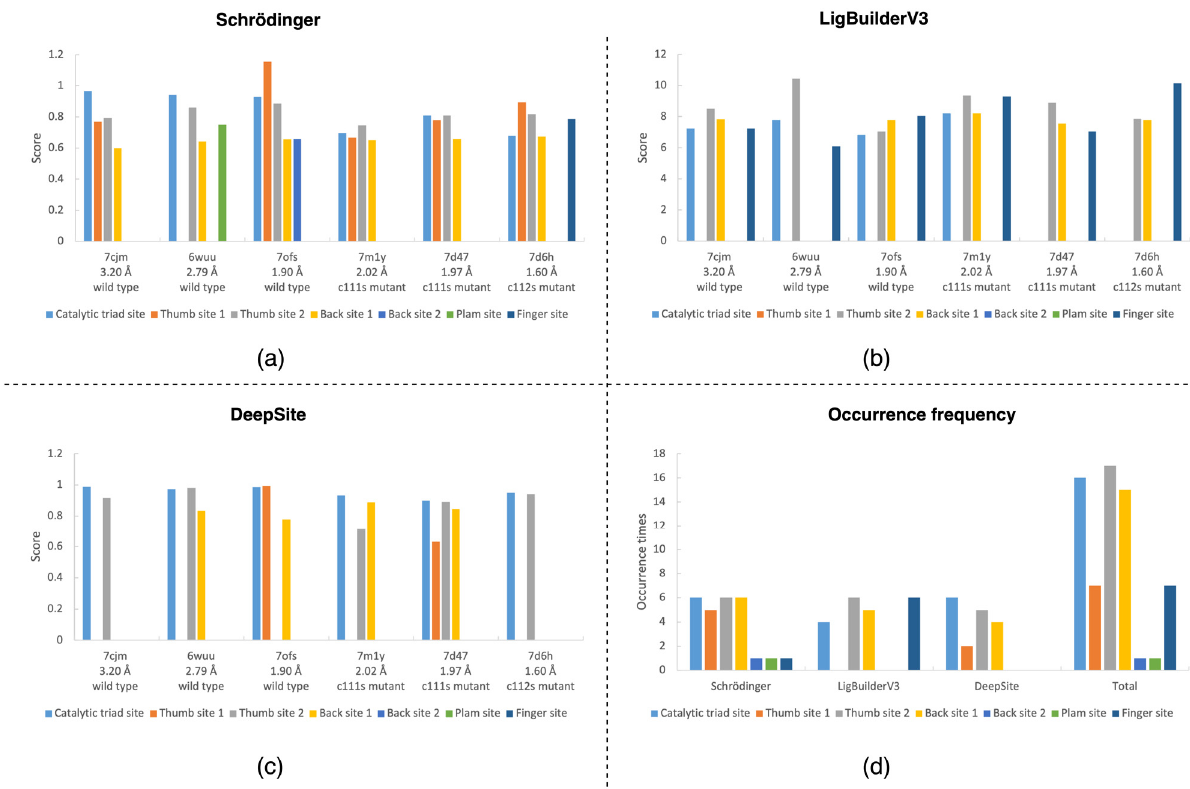
Figure 3. Site detection location map and main sites score statistics: ( a ) Schrödinger’s sitemap results. ( b ) Cavity of LigBuilderV3 test results. ( c ) Binding site detection results of DeepSite. ( d ) Statistics of the detected number of main sites.